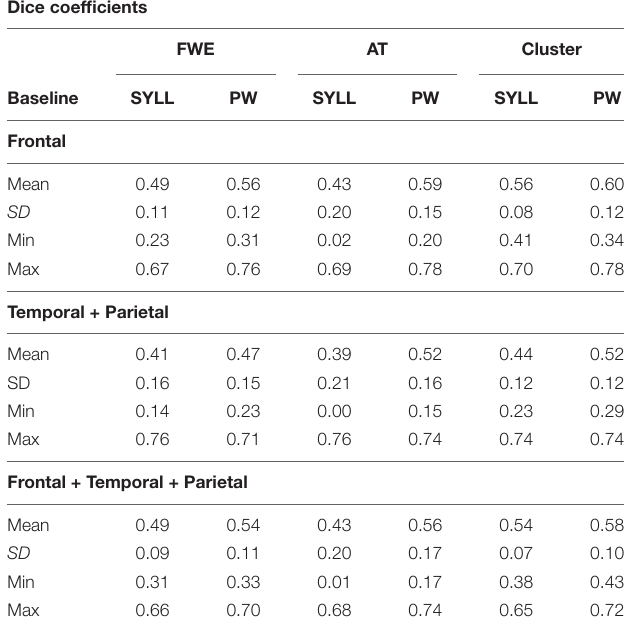
TABLE 1 | Dice coefficients in the two paradigms (SYLL: syllable baseline vs. PW: pseudoword baseline) in three regions (frontal, temporal-parietal, and frontal-temporal-parietal) at three statistical thresholds [FWE, FWE correction for multiple comparisons at α = 0.05; AT, adaptive thresholding as implemented in Gorgolewski et al. (2012) at α = 0.05; Cluster, cluster correction at voxel-wise α = 0.001 and cluster-wise α = 0.05 FWE-corrected].